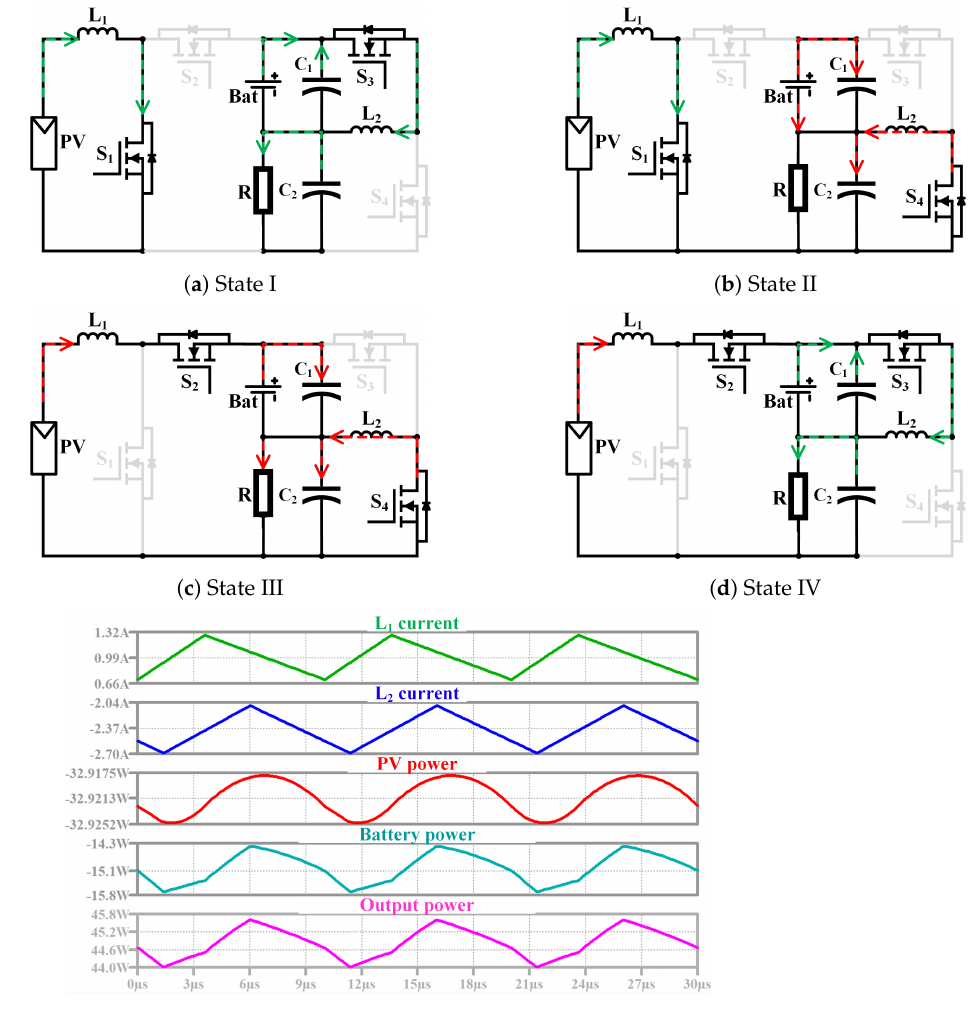
Figure 12. Type I-III-IC circuit Mode 6